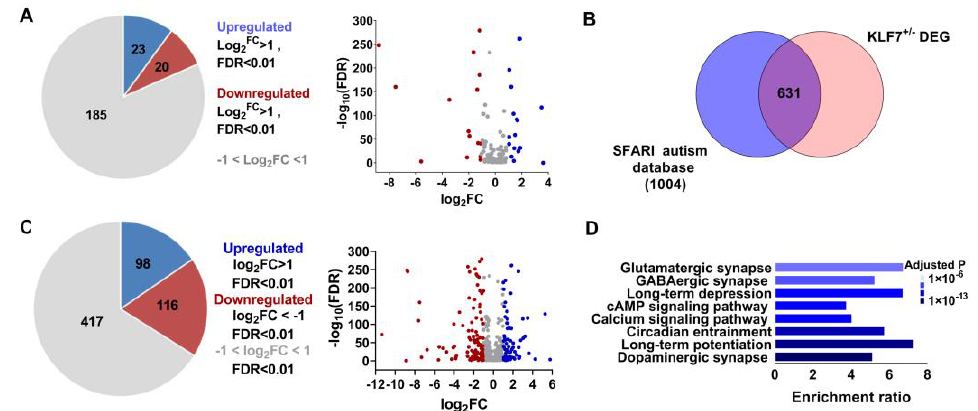
Figure 3. ASD risk genes are dysregulated in klf7 +/− mice. ( A ) Some klf7 target ASD risk genes were strongly dysregulated in klf7 +/− mice compared with WT mice. Of the 228 ASD risk genes targeted by klf7, the expression levels of 43 genes were significantly altered, with 23 being upregulated and 20 being downregulated (log2FC > 1 or log2FC < − 1, false discovery rate (FDR) < 0.1). ( B ) A total of 631 genes were both identified as DEGs in klf7 +/− mice and found in the SFARI database. The number of ASD risk genes in the SFARI database disrupted by klf7 loss is indicated, and the total number in each subset is presented in parentheses. ( C ) Of the 631 autism genes in ( B ) that were disrupted by klf7 deletion, 98 were significantly upregulated (log2FC > 1), 116 were significantly downregulated (log2FC < − 1), and 417 showed minimal changes ( − 1 < log2FC < 1). ( D ) The 631 autistic genes disrupted in klf7 +/− mice shown in ( B ) were functionally annotated. n = 4 for A; klf7, Krüppel-like transcription factor 7; ASD, autism spectrum disorder; DEGs, differentially expressed gene; SFARI, Simons Foundation Autism Research Initiative; log2FC, log2(Fold Change); TFs, transcription factors.